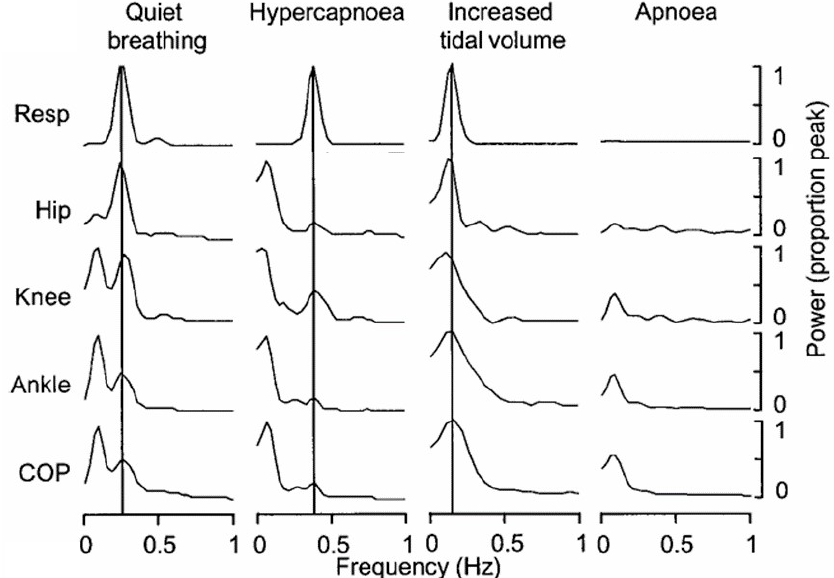
Figure 6. Investigation of the influence of respiration on the activity of the neck, hip, knee and ankle and the resulting effect on the CoP (adapted by Hodges et al., 2002).